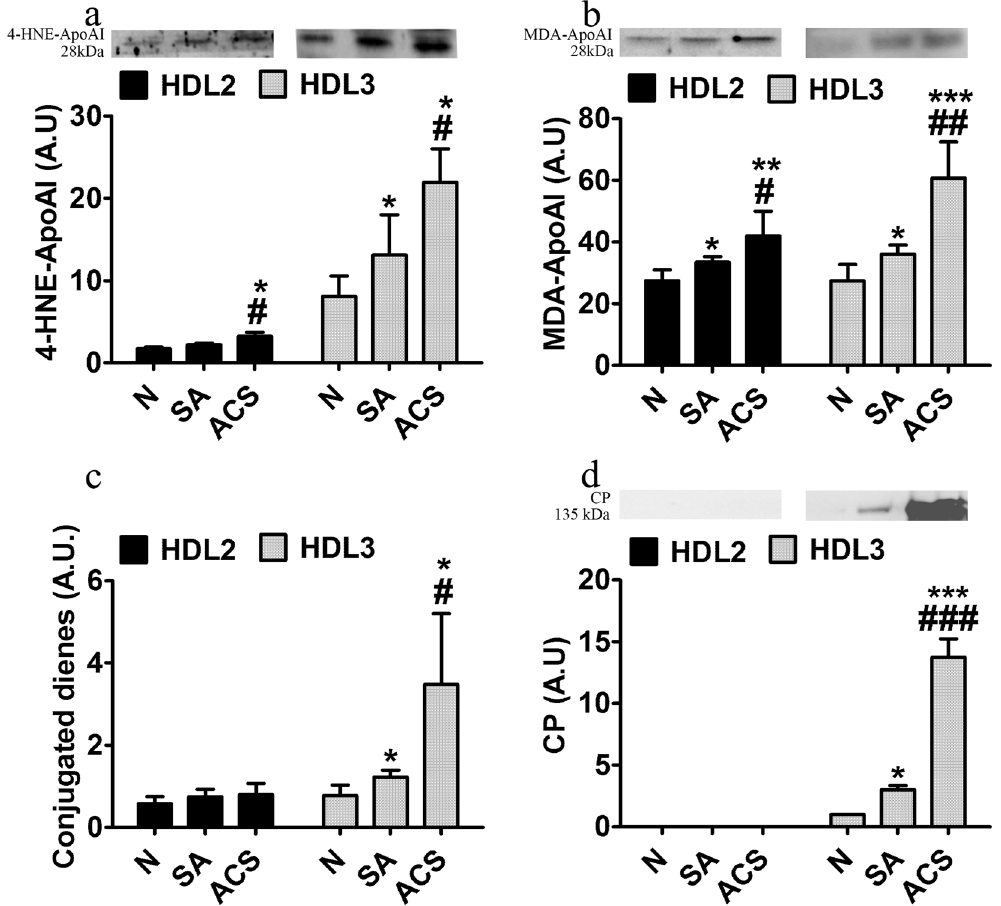
Figure 4. Characterization of oxidative markers in HDL 2 and HDL 3 subfractions isolated by density gradient ultracentrifugation from seven independent pools of sera from healthy subjects (N), stable angina patients (SA) and acute coronary syndrome (ACS) patients. Levels of 4-hydroxy-2-nonenal associated to apolipoprotein AI (4-HNE-apoAI) ( a ), malondialdehyde associated to apolipoprotein AI (MDA-apoAI) ( b ), conjugated dienes ( c ) and ceruloplasmin (CP) ( d ). The western blot images were processed by cropping the corresponding parts from the blots. The full-length blots are supplied in the Supplementary information. Data are expressed as means ± SD and analyzed with Independent Student’s T-test; * p < 0.05, ** p < 0.01, *** p < 0.001 vs. N, # p < 0.05, ## p < 0.01 vs.